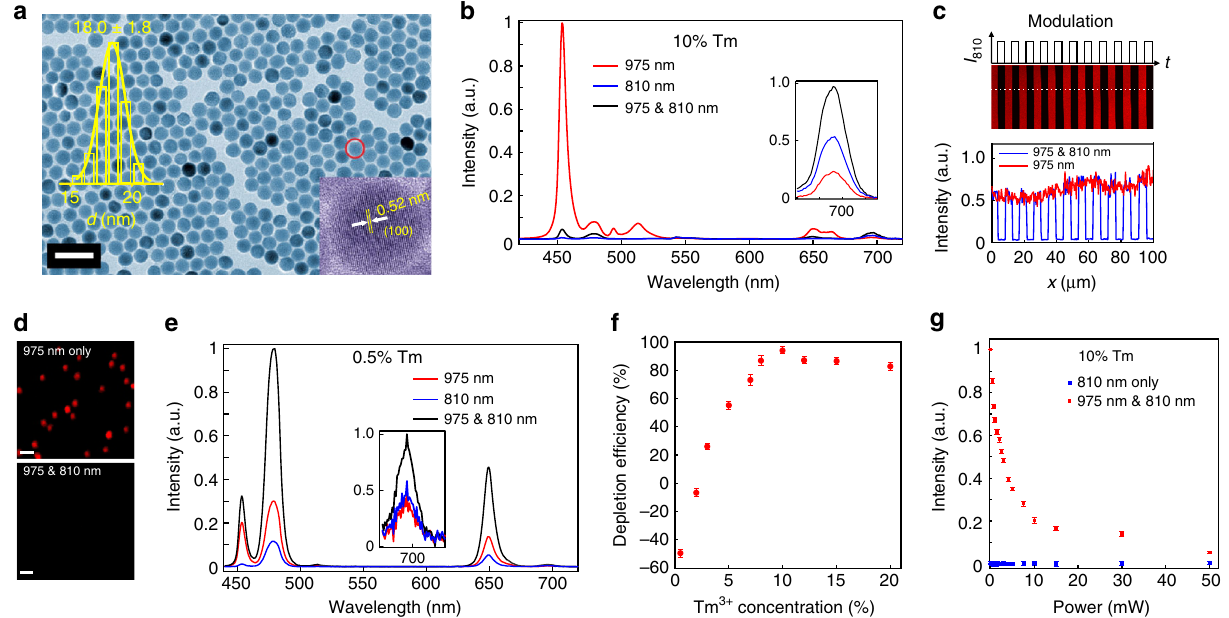
Fig. 1 Optical depletion of the 455-nm upconversion luminescence of NaYF 4 :18% Yb 3+ , 10% Tm 3+ UCNPs. a TEM images of NaYF 4 :18% Yb 3+ , 10% Tm 3+ UCNPs. Insets: the distribution of the nanoparticle diameters and a high-resolution TEM image, revealing the highly crystalline nature of the nanocrystals. (cid:1) (cid:3) (cid:1) I 975 & 810 = I 975 Scale bar: 50 nm. b Ninety-six percent depletion ef fi ciency (DE, I 975 )) of the 455-nm emission from NaYF 4 :18% Yb 3+ , 10% Tm 3+ ( λ exc = 455 455 455 975 nm (CW), λ depletion = 810 nm (CW)). c The upconversion imaging of NaYF 4 :18% Yb 3+ , 10% Tm 3+ UCNPs fi lm on slides with modulated 810-nm laser co-irradiation. d The upconversion imaging of single or sparse nanoparticles on slides with/without 810-nm laser co-irradiation. Scale bar: 2.5 μ m. e The emission spectra of NaYF 4 :18% Yb 3+ , 0.5% Tm 3+ nanoparticles on glass slides excited by 975-nm CW solely, 810-nm CW solely, 975-nm and 810-nm CW simultaneously. f The depletion ef fi ciencies of the 455-nm emission of NaYF 4 :18% Yb 3+ , x% Tm 3+ UCNPs with different Tm 3+ doping concentrations (0.5, 2, 3, 5, 7, 8, 10, 12, 15, and 20%). Negative depletion ef fi ciency represents emission enhancement. The power density of the 975-nm laser is 700 kW cm − 2 , and the power density of 810-nm laser is 17.7 MW cm − 2 . Error bars represent ± 1 s.d. g The power-dependent depletion ef fi ciency and the background 455- nm emission intensity excited solely by the 810-nm beam of NaYF 4 :18% Yb 3+ , 10% Tm 3+ UCNPs. The saturation intensity I sat (50% off) is estimated to be 849 kW cm − 2 (about 2.4 mW). Error bars represent ± 1